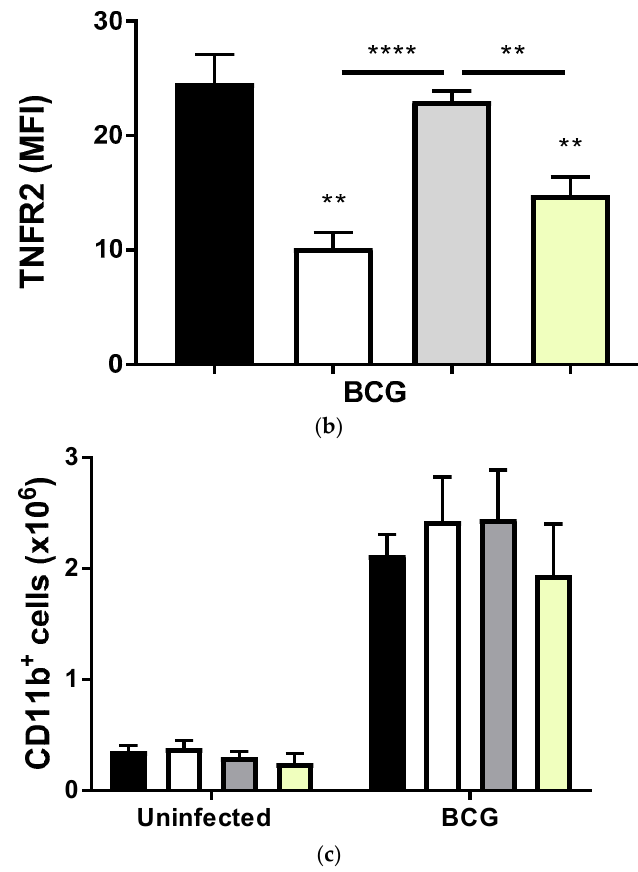
Figure 2. The expression of TNFR2 in pleural myeloid cells after BCG-induced pleurisy in mice. ( a ) Frequency of CD11b+ or myeloid cells expressing TNFR2; ( b ) Mean fluorescence intensity of TNFR2 expressed by pleural myeloid CD11b+ cells. Cells were isolated from the pleural cavity of BCG-infected mice at day 14 post-infection. Data are represented as bar graphs showing means +/ − SEM. n = 9 to 11 mice/per group. Comparisons are done between infected WT mice versus infected mutant mice or as indicated in the figure. ** p < 0.01, *** p < 0.001, and **** p < 0.0001 versus WT if not indicated otherwise; ( c ) Absolute number of CD11+ cells isolated from the pleural cavity of uninfected or infected mice at day 14 post-infection. Data are represented as bar graphs showing means +/ − SEM ( n = 2 to 4 uninfected condition and n = 9 to 12 for BCG-infected mice/per group). No statistical difference is observed between mouse genotypes.